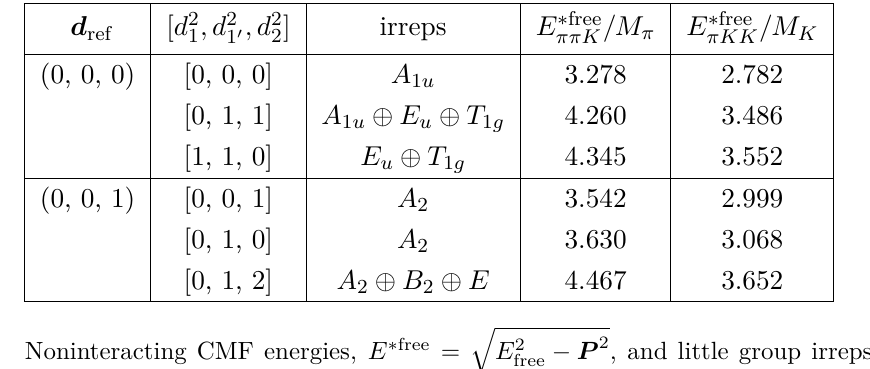
Table 3. Noninteracting CMF energies, E ∗ free = π + π + K + and π + K + K + levels appearing in figure 4. Frames are denoted by d ref = P L/ (2 π ) . Orbits are specified by the squared momenta of the three particles, e.g. d 2 labels are { 1 , 1 0 , 2 } = { π + , π + , K + } for π + π + K + , and { 1 , 1 0 , 2 } = { K + , K + , π + } for π + K + K + .